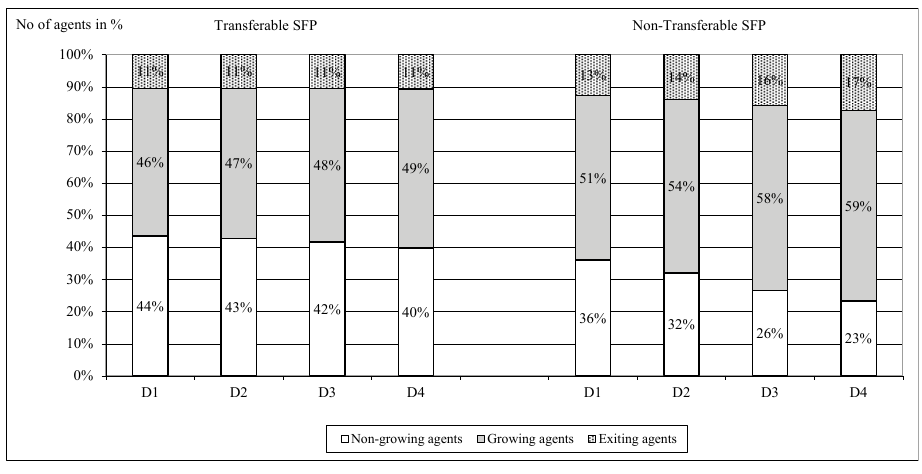
Figure 5. Share of growing, non-growing and exiting agents in the transferable and non-transferable SFP scenarios.